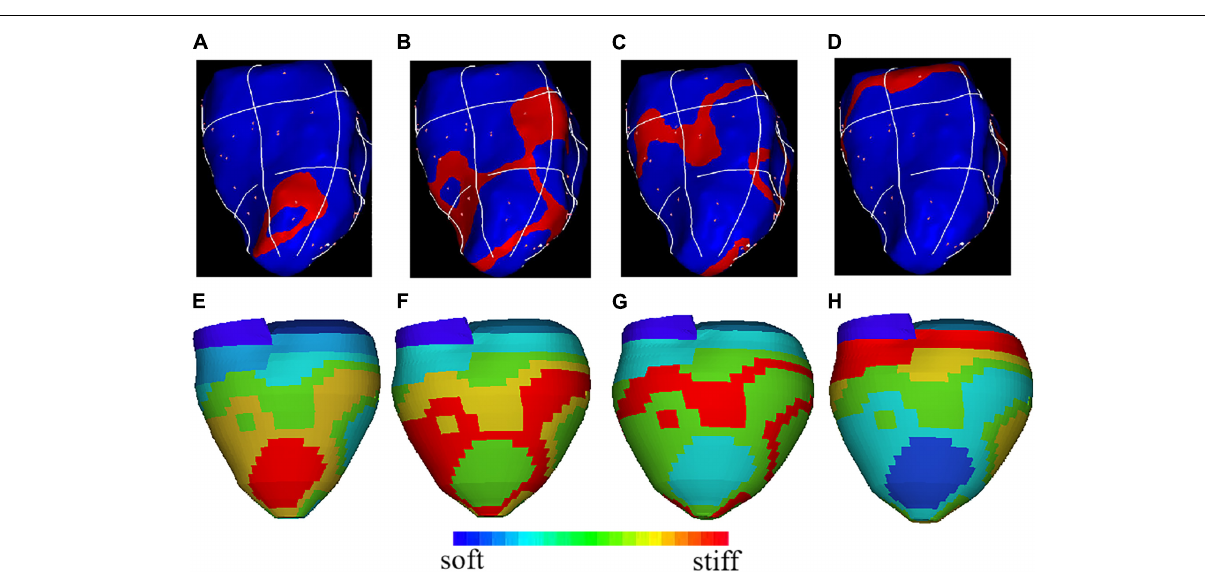
Frontiers in Physiology |